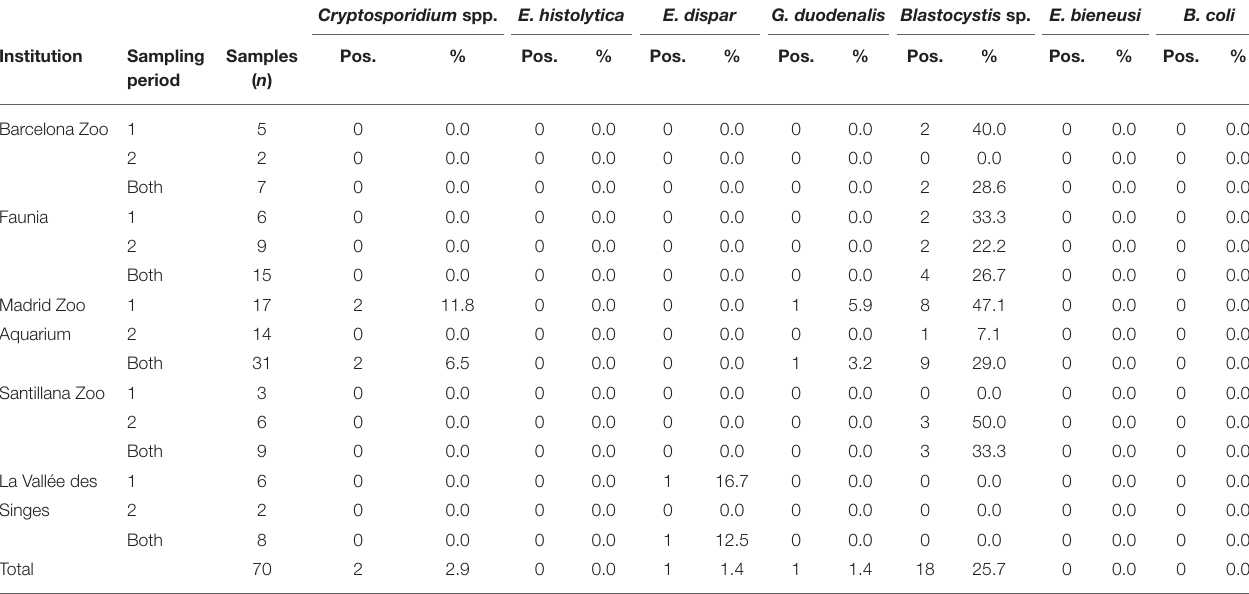
TABLE 3 | Frequency of intestinal protist species detected in zookeepers handling non-human primates by participating institution and sampling period in the present study. Cryptosporidium spp. E. histolytica E. dispar G. duodenalis Blastocystis sp. E. bieneusi B. coli Institution